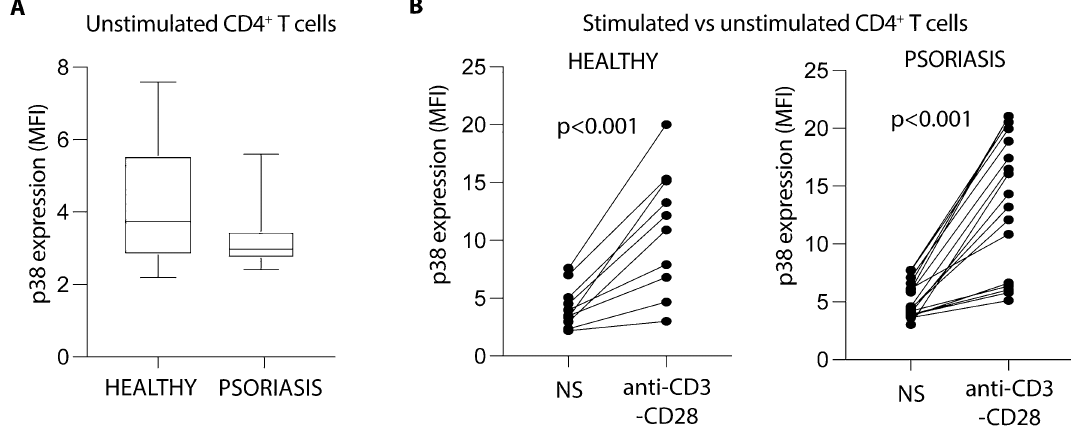
Figure 4. p38 activation is not affected in CD4 + T cells from psoriasis patients. ( A ) Dual phosphorylation of p38 was evaluated by flow cytometry in peripheral blood CD4 + T cells from psoriasis patients (n = 16) and healthy subjects (n = 10), immediately after isolation. Data were analyzed using Mann–Whitney U test. ( B ) Activation of p38 before and after TCR stimulation. T cells were either left untreated (not stimulated, NS) or activated in the presence of anti-CD3 (10ug/ml) and anti-CD28 (5ug/ml) antibodies during 15 min. Thereafter, dual phosphorylation of p38 was evaluated by flow cytometry as in A. Data were analyzed using Wilcoxon matched signed rank test.